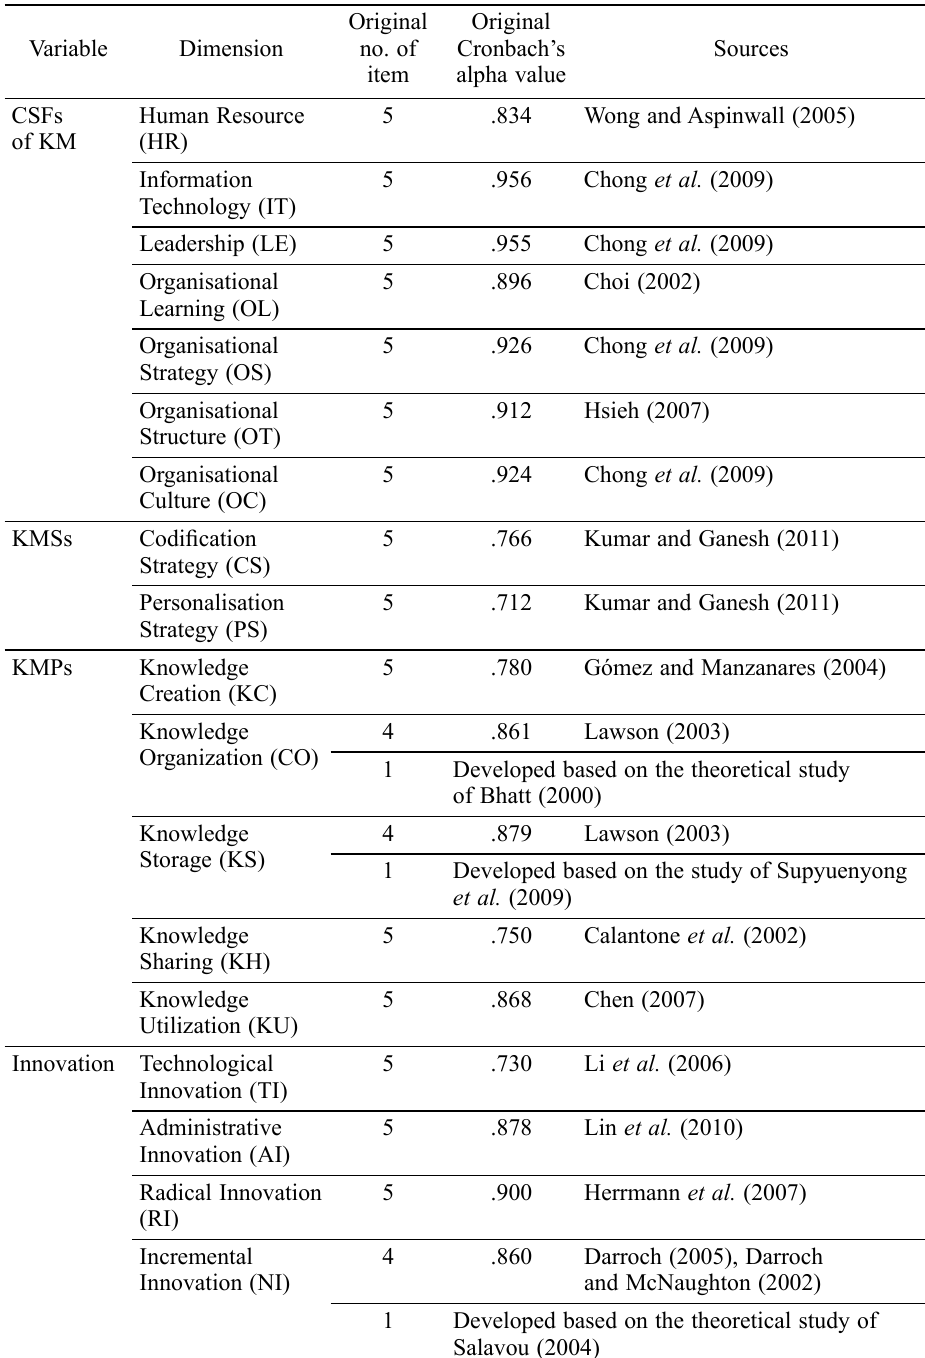
Table 1. Measurement